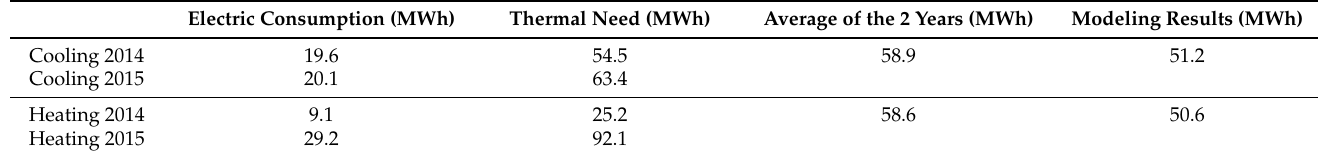
Table 2. Annual energy modeling in TRNSYS18 compared to